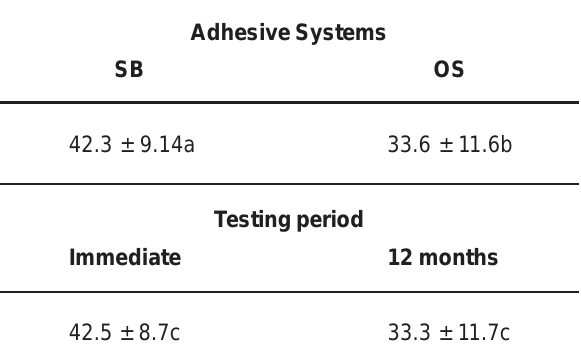
*Different letters indicate statistically significant difference in each